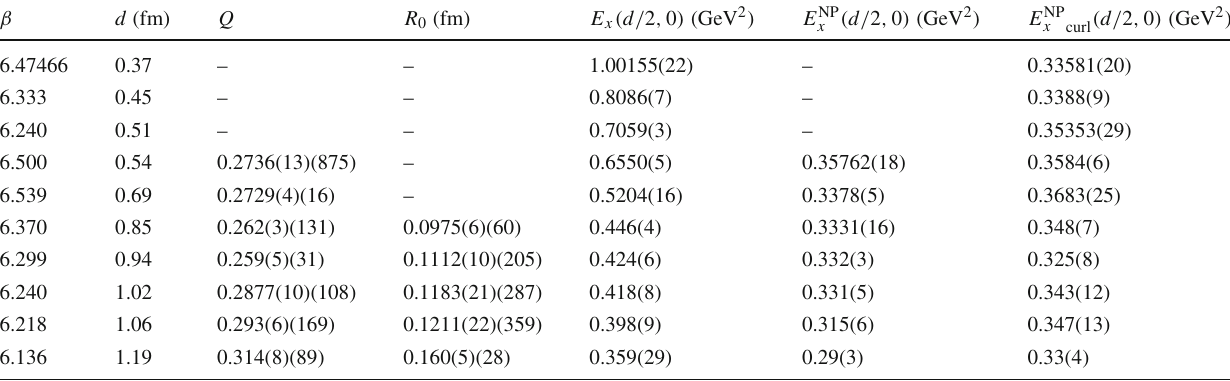
Table 2 Valuesof the fitparameters Q and R 0 extractedfrom Coulomb fits of the transverse components of the chromoelectric field and val- ues of the longitudinal chromoelectric fields at ( d / 2 , 0 ) , the mid- point between the sources and transverse distance zero, for several values of distance d . E x ( d / 2 , 0 ) is the unsubtracted simulated field and E NP x ( d / 2 , 0 ) is the non-perturbative chromoelectric field. For com- parison, in the last column the non-perturbative chromoelectric field ( d / 2 , 0 ) obtained using the irrotational property of the pertur- E NP x curl